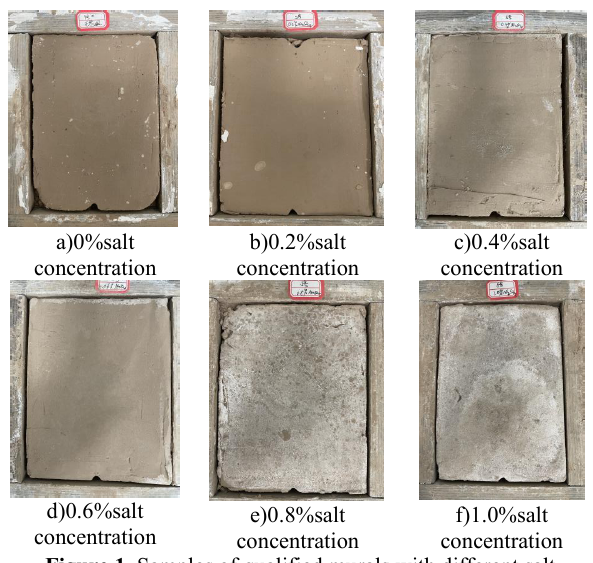
Figure 1. Samples of qualified murals with different salt concentrations